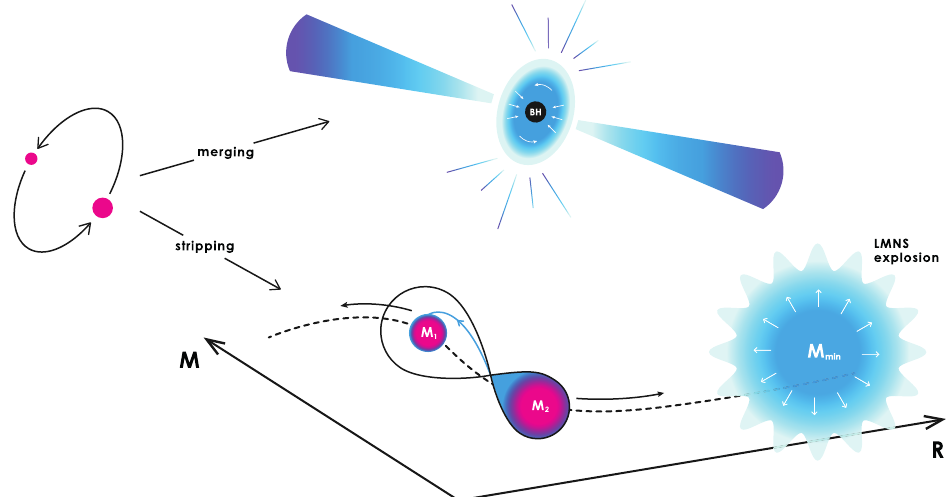
Figure 1. A sketch of the mechanisms of merging (arrow up) and stripping (arrow down). See text for